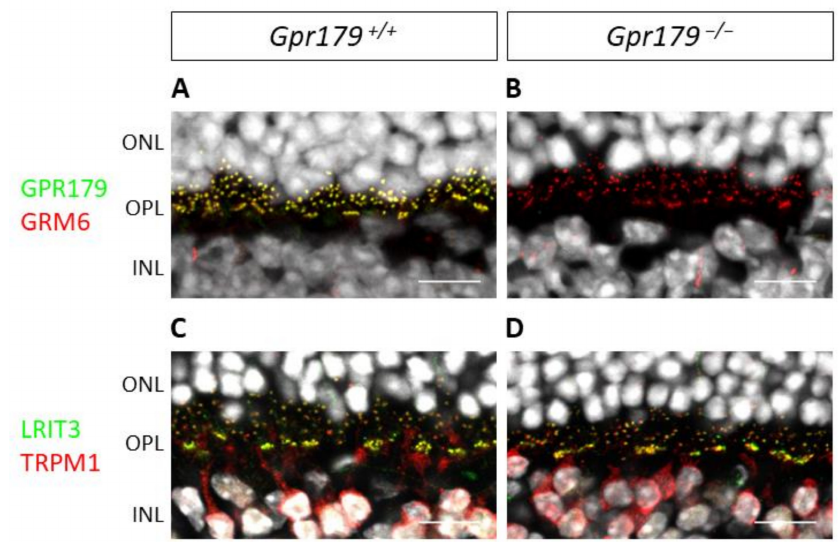
Figure 7. Localization of GRM6, TRPM1, and LRIT3 at the dendritic tips of ON-bipolar cells is independent of Gpr179 expression. Representative confocal images of Gpr179 +/+ and Gpr179 − / − mouse retinal sections. Gpr179 +/+ ( A ) and Gpr179 − / − ( B ) mouse retinal sections were stained with anti-GPR179 (green), anti-GRM6 (red), and DAPI (white). Gpr179 +/+ ( C ) and Gpr179 − / − ( D ) mouse retinal sections were stained with anti-LRIT3 (green), anti-TRPM1 (red), and DAPI (white).